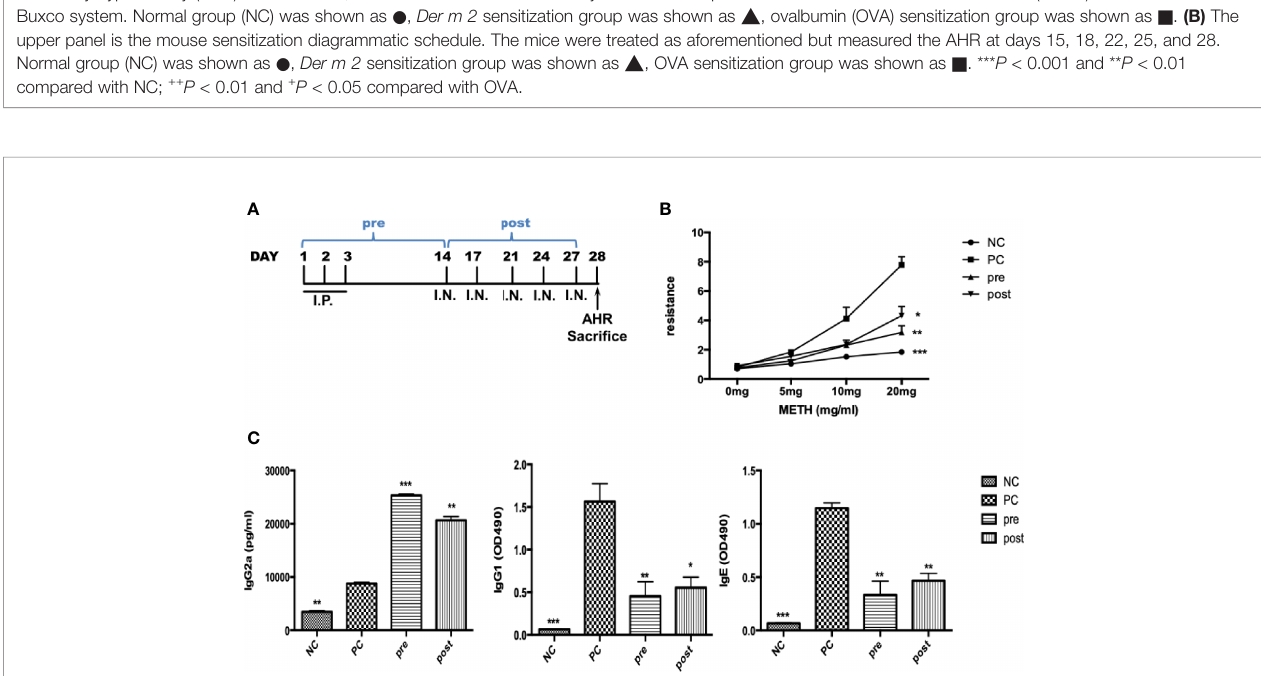
FIGURE 6 | The effect of FIP- fve on AHR and immunoglobulins in recombinant Der m 2 -sensitized BALB/c mice. (A) The draft of mouse sensitization schedule. The mice were intraperitoneally injected allergen or not in the fi rst 3 days and were administered intranasal allergens at days 14, 17, 21, 24, and 27; total of 5 days. After the AHR determination, the mice were euthanized at day 28. The “ pre ” means the oral administration of FIP- fve once a day in the fi rst 14 days, and “ post ” means the administration of FIP- fve in the last 14 days. (B) The mouse ’ s AHR to methacholine (METH) assessed with the Buxco system. Normal group (NC) was shown as ● , Der m 2 (PC) sensitization group was shown as ■ , pre group was shown as ▲ , and post group was shown as ▼ . (C) Allergen-speci fi c IgE, allergen-speci fi c IgG1, and allergen-speci fi c IgG2a in sera were determined from the NC group, Der m 2 -sensitized, and FIP- fve treatment (pre, post) mice. Results are representative of two independent experiments. *** P < 0.001, ** P < 0.01, and * P < 0.05 compared with PC.